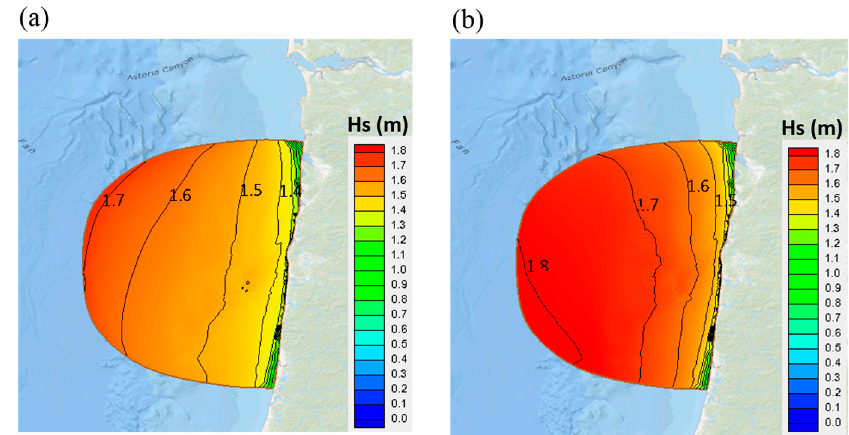
Figure 10. Modeled 2D significant wave height distribution with UnSWAN (L) ( a ) no wind—July average, 2009; ( b ) with wind—July average, 2009.